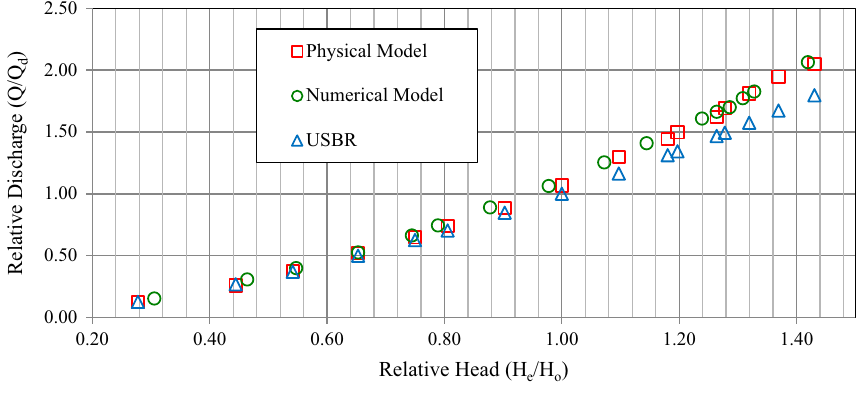
Fig. 16 Comparison of numeri- cal, physical and USBR models